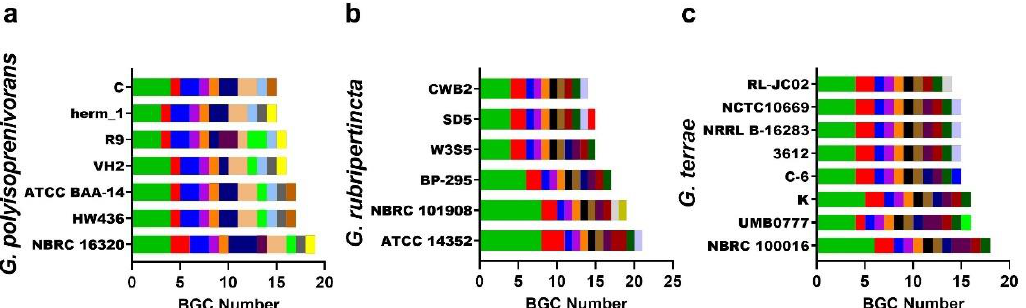
Figure 10. Intraspecies variability of BGC content. ( a ) G. polyisoprenivorans strains NBRC 1632, HW436, ATCC BAA-14, VH2, R9, herm_1 and C; ( b ) G. rubripertincta strains ATCC 14352, NBRC 101908, BP-295, W3S5, and cwb2; ( c ) G. terrae strains NBRC 100016, UMB0777, K, C-6, 3612, NRRL B-16283, NCTC10669, and RL-JC02. The color code corresponds to the same classification indicated in Figure 9a; for a detailed list, see Table S10.